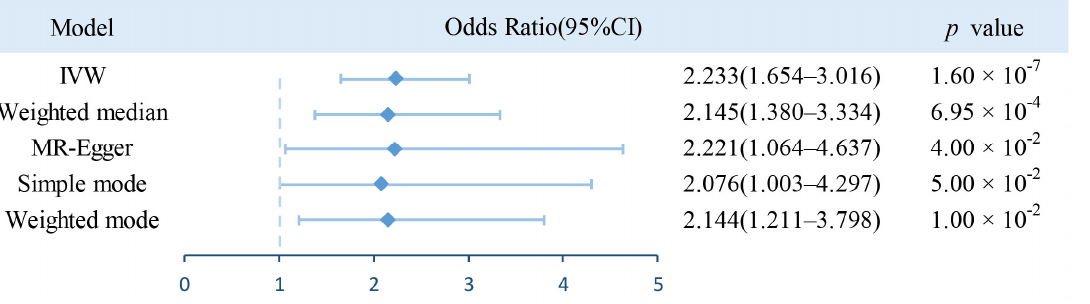
Figure 3. Outliers identified by Radial Mendelian randomization method. IVW, inverse variance weighted.